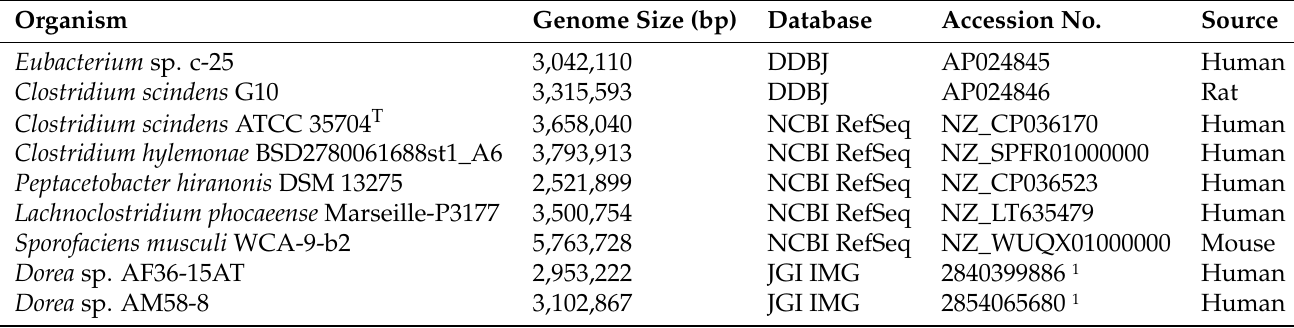
Table 1. Genome information of the strains used in bioinformatics